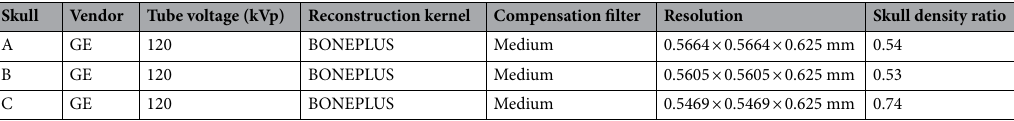
Table 2. CT parameters used for imaging the three ex vivo